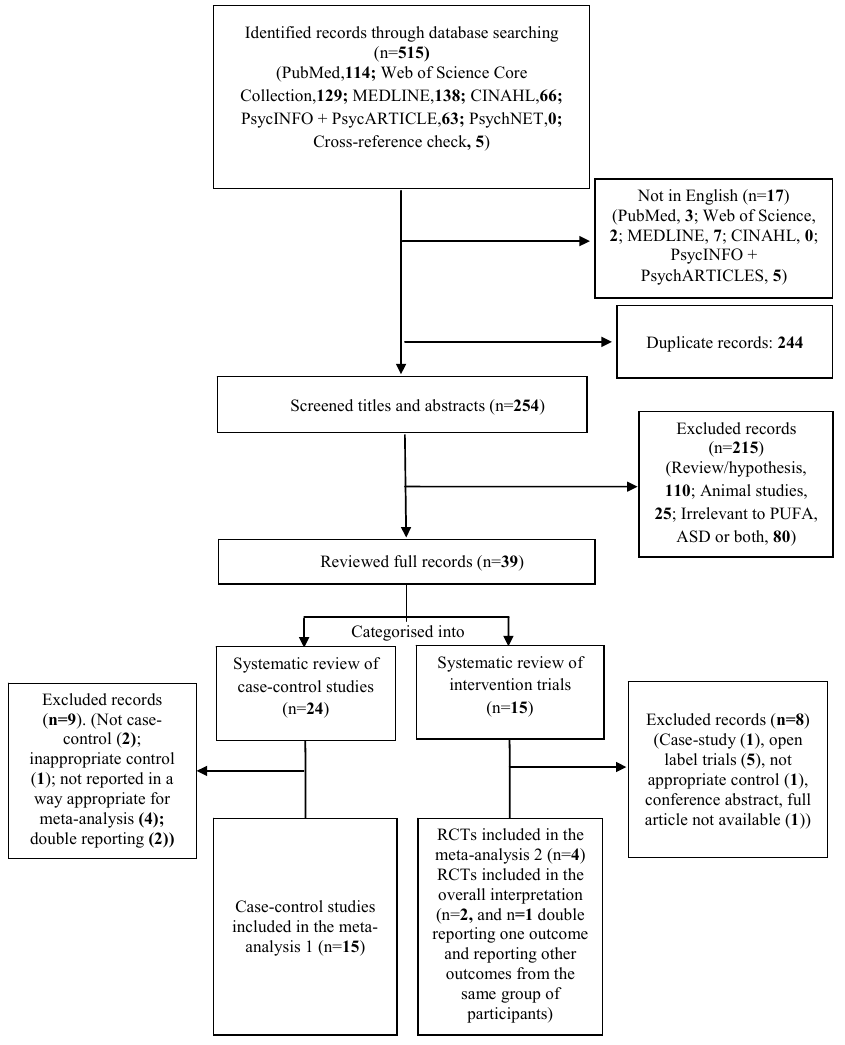
Figure 1. Flow diagram for selection of studies (PRISMA flow diagram).